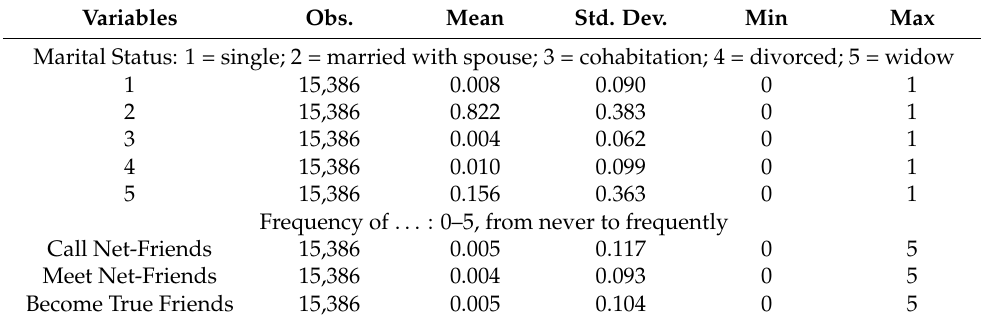
Table 1. Cont. Variables